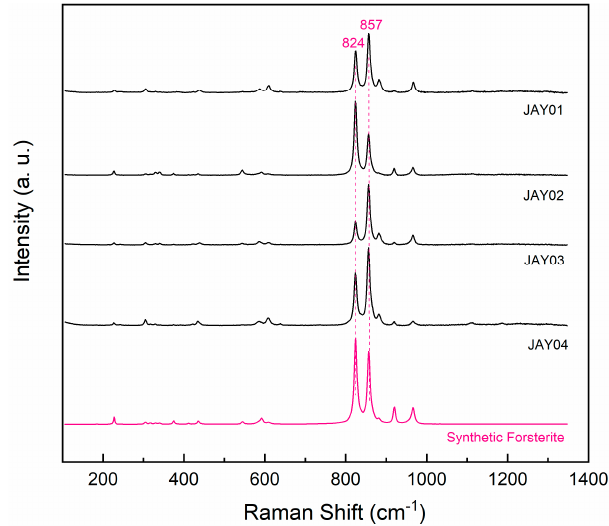
Figure 5. Typical Raman spectra of the olivines from jianite. Text next to the Raman spectrum is the label of the sample (JAY01, JAY02, JAY03, or JAY04). The Raman spectrum of the synthetic forsterite (Mg# = 100) is from Liu et al. [29]. The major Raman feature of the olivine is the two peaks occurring at ~815–825 cm − 1 and ~838–857 cm − 1 . To illustrate clearly, only one Raman spectrum is shown for each sample, although multiple Raman spectra have been collected.